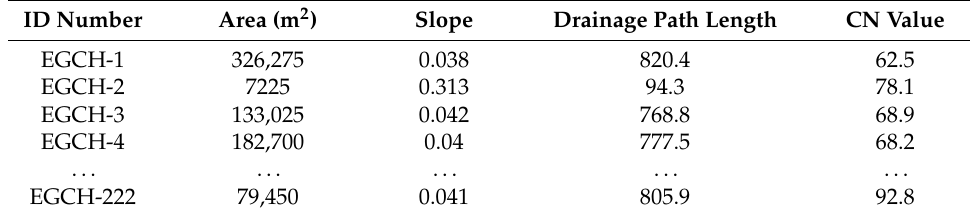
Table 1. Watershed catchment area parameters.